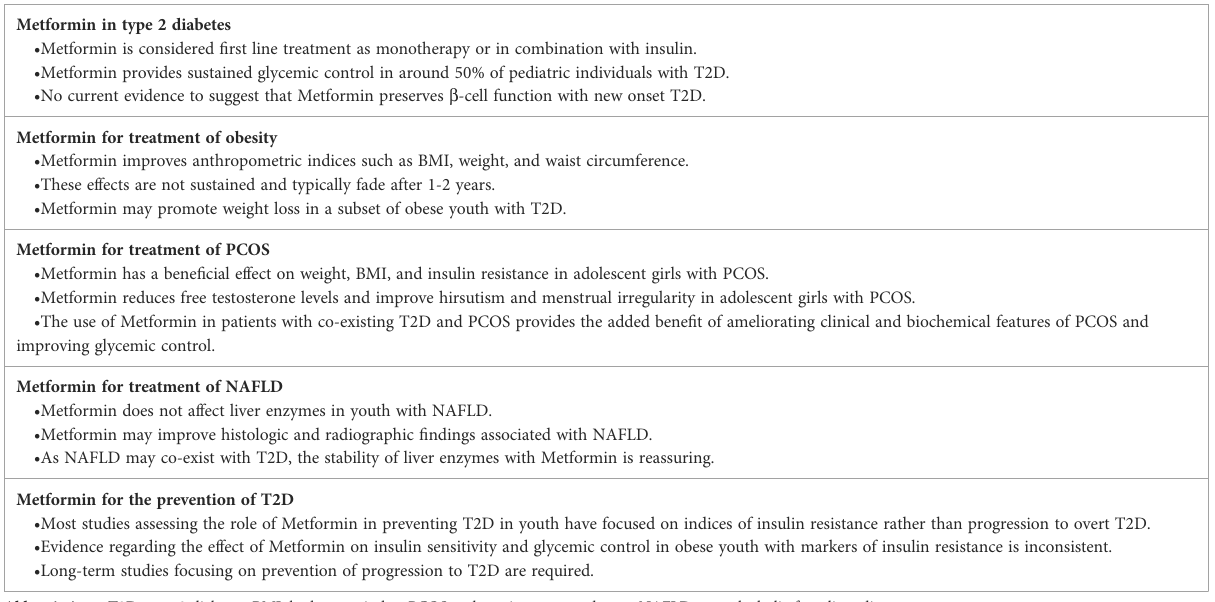
TABLE 2 Summary of Metformin